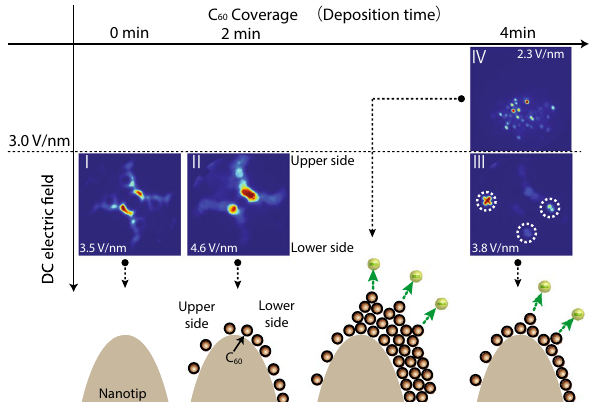
Figure 2. Summary of the deposition time and DC-electric-field dependences of FEM images together with their interpretations. Deposition time and DC-electric-field dependences of the FEM images of molecules. The temperature of the evaporator boat was 420 °C. The value of the DC electric field at the top of the tip apex, F DC is denoted in each image. A schematic diagram of the interpretation of each image is also depicted. F DC V tip , where V was determined using the following equation: F DC = tip is the voltage applied to the tip, r is the kr tip radius, and k is a parameter that varies depending on geometrical factors, such as tip shape, geometries of surrounding electrodes and polar angles of the sphere of the tip apex 7 . In this particular case, we determined k top , which is defined at the very top of the tip apex. The tip radius was separately measured once using a scanning electron microscope (SEM). In addition, before each experiment, we recorded threshold tip voltages at which the electron signals from the field emission could be seen on a phosphor screen. Here, we assumed that the F DC for the threshold voltages is constant as long as the tip surface conditions, such as material and cleanliness, are the same. The threshold voltage is inversely proportional to the tip radius under this assumption. At each experiment, we determined the tip radius by multiplying the tip radius that was measured using the SEM by a proportion determined by the changes in threshold voltages. The parameter, k, was determined by fitting the theoretical FN curves provided in the references 18,19 onto the experimentally obtained FN plots. The signals for the FN plots were taken from the (310) type facets of a tungsten tip, as indicated by the rectangles in the inset of Fig. 4e. There are three fitting parameters: temperature, work function and k . The previously obtained value of 4.45 eV was used for the work function 20 . The temperature was set to room temperature or 300 K. The k parameter was determined by a curve fitting using the FN plots. Thus, the obtained k value for the (310) type facets was multiplied by a factor of 1.04 to obtain k top 7 . The uncertainty of F DC determined in this method is 20 percent at most 7